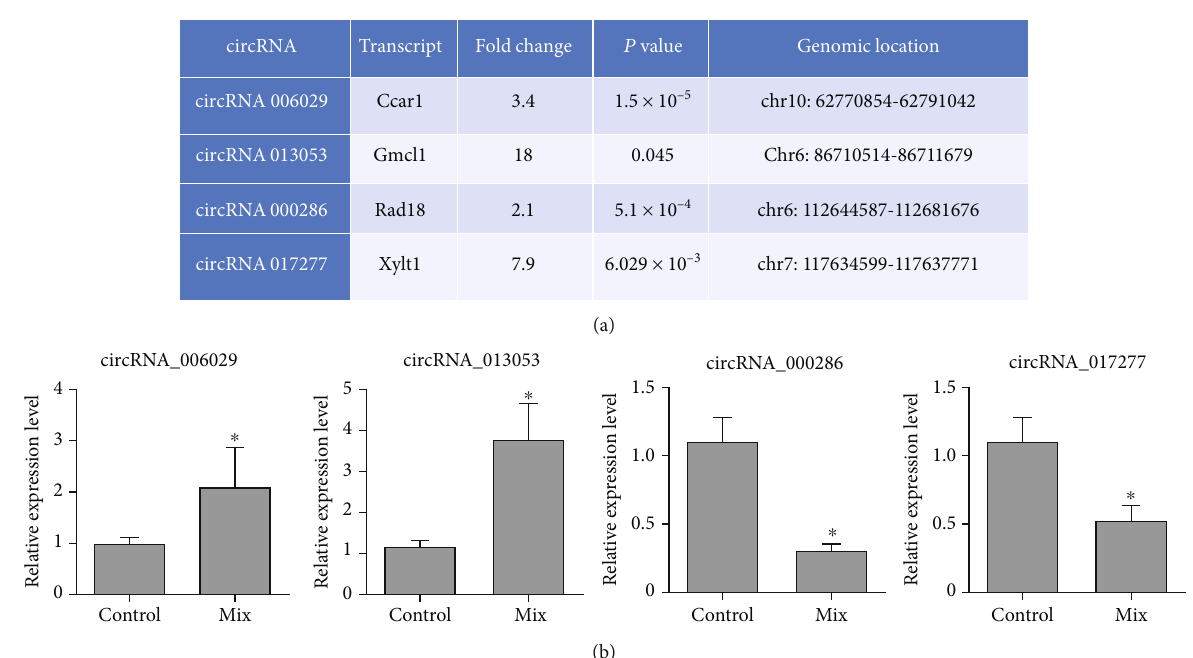
Figure 2: Validation for the expression of four dysregulated circRNAs. (a) The four dysregulated circRNAs were selected and shown with fold changes, P values, and genomic locations. (b) The expression of the four selected circRNAs were changed by proin fl ammatory cytokines. MIN6 cells were incubated in the absence or presence of 2.5ng/mL IL-1 β , 2.5ng/mL TNF- α , and 25ng/mL IFN- γ (24 h incubation). The expression levels were measured by qRT-PCR. The results are shown as means ± SD for three independent experiments. ∗ P < 0 : 05 , compared with control